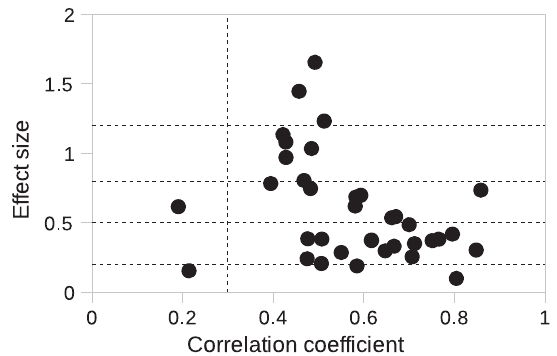
FIG. 5. Effect size as a function of the correlation coefficient estimated using ML for the 37 ConcepTests. Horizontal lines correspond to values for small (0.2), medium (0.5), large (0.8), and very large (1.2) effect sizes. The vertical line corresponds to ρ ¼ 0 . 3